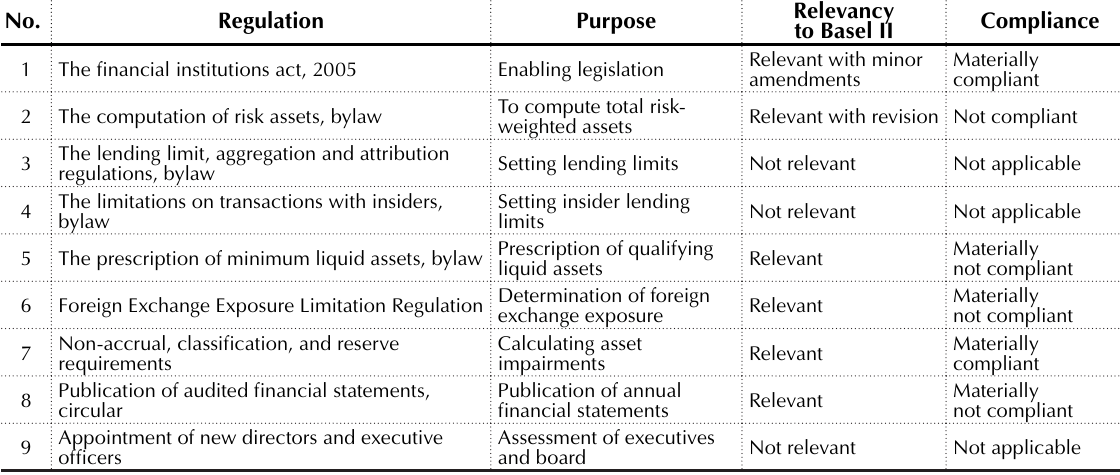
Table 1. Assessment of the current regulatory framework